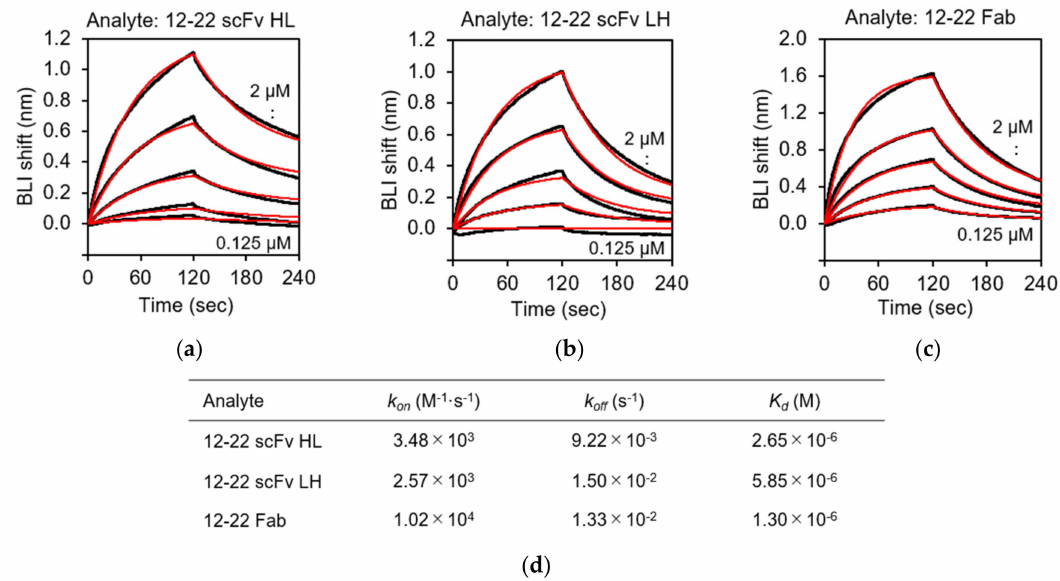
Figure 6. Binding analysis of rRABVG by 12–22 fragments. Representative sensorgrams for the binding responses between rRABVG and ( a ) 12–22 scFv HL; ( b ) 12–22 scFv LH; and ( c ) 12–22 Fab. Sensorgrams were globally fitted with 1:1 binding model (red lines). ( d ) Affinity constants ( K d ), association ( k on ), and dissociation ( k off ) rate constants were derived by nonlinear curve fitting using BLItz Pro version